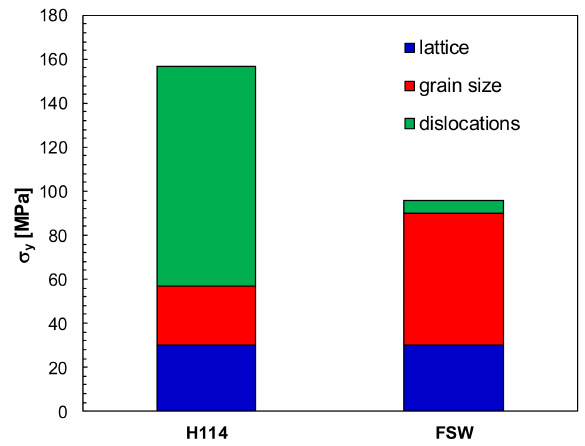
Figure 10. Quantification of the strengthening contributions given by the different